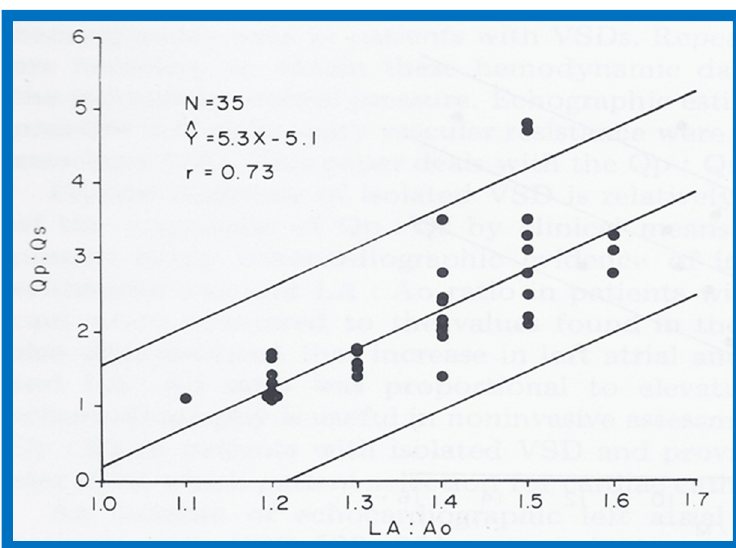
Figure 2. Scattergram demonstrating the relationship of the left atrium to aortic root ratio (LA:Ao) with pulmonary-to-systemic flow ratio (Qp:Qs) in patients with isolated ventricular septal defects. The central lines and insert are as in Figure 1. Reproduced from Rees AH, Rao P.S., et al. [1].